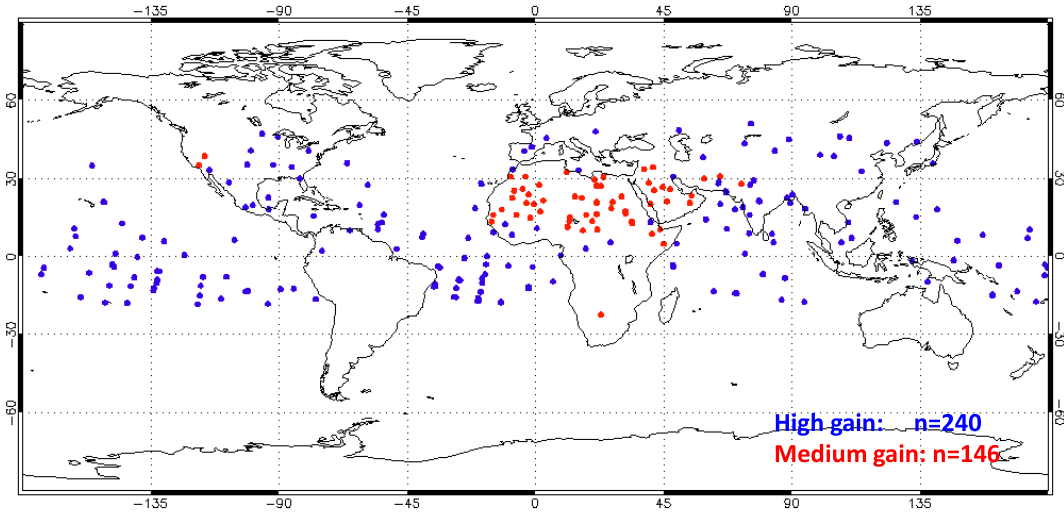
Figure 4. The match-up points between GOSAT and OCO-2 used in the spectral radiance comparison. Blue and red dots represent the GOSAT high and medium gain observations, respectively. Numbers of match-up points are 240 for high gain and 146 for medium gain.